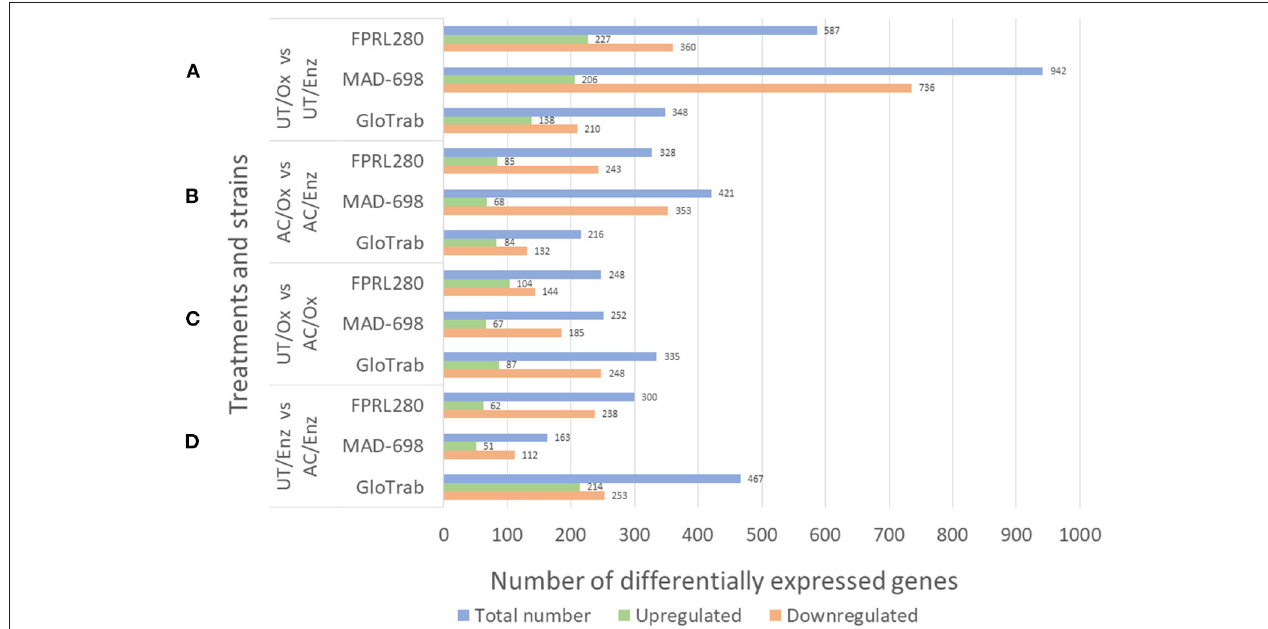
FIGURE 1 | Results for the differential expression analysis of the treatment and decay stage comparison of the three brown rot strains R. placenta FPRL280 and MAD-698 and G. trabeum (GloTrab). The treatments that were compared are untreated (UT) and 15 % acetylated (AC) samples, at different decay stages: early oxidative decay (Ox) and later enzymatic decay (Enz). (A) Shows the comparison of the oxidative (Ox) and the enzymatic (Enz) phase in untreated (UT) samples. (B) Compares the oxidative and the enzymatic phase, but in acetylated samples. (C) Compares the oxidative phases of untreated and acetylated samples. (D) Shows the comparison of untreated and acetylated samples during the enzymatic decay